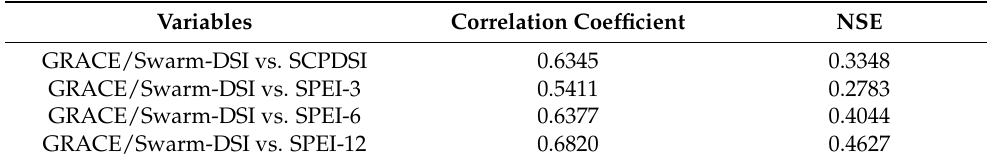
Table 5. The correlation coefficients and NSE between GRACE/Swarm-DSI and four tradition drought indices (The correlation coefficient results have passed the 99% confidence level). Variables Correlation Coefficient NSE